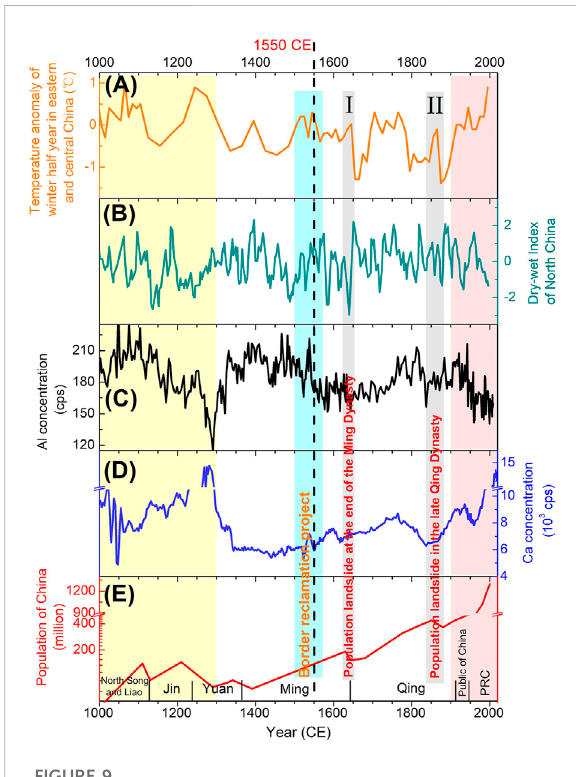
FIGURE 9 (A) Temperature anomaly for the winter half year in eastern and central China (Ge et al., 2003b), (B) dry-wet Index in North China (Zheng et al., 2006), (C,D) Al and Ca concentrations, and (E) population (Cao and Ge, 2005) since 1000 CE. In the past 1000 years, there were no signi fi cant changes in China ’ s regional population proportion, so the historical sequence of population of the whole China can indicate the changes in intensity of human activities around Gonghai Lake. The yellow shadow indicates the Medieval Warming Period (MWP), the pink shadow indicates the Current Warming Period (CWP), the dash-dotted line is the boundarybetweenLittleIceAge-1(LIA-1)andLittleIceAge-2(LIA- 2), the cyan column indicates the border reclamation project period, and the 2 gray columns indicate the periods of population crashes. PRC is the abbreviation for People ’ s Republic of